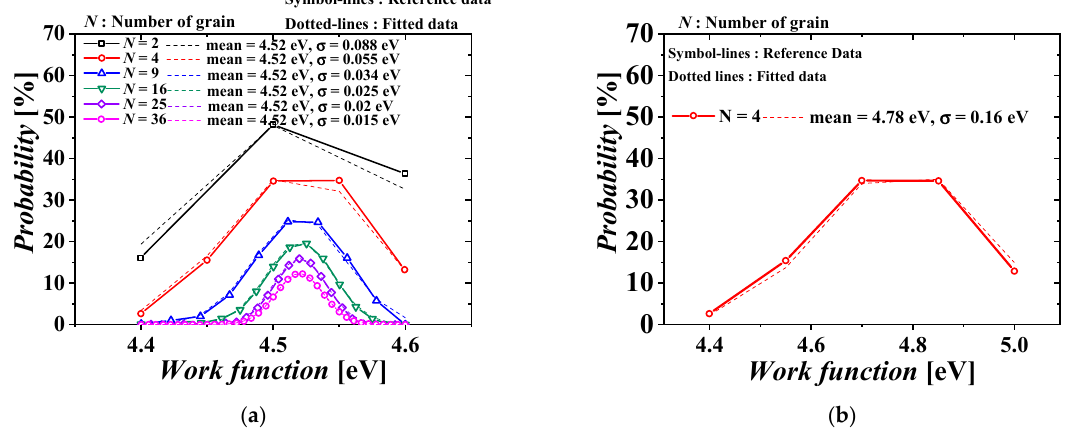
Figure 2. Work-function distributions in metal gates of each tier MOSFET. ( a ) TiN metal gate with the grain size of 5 nm of the top-tier NMOSFET (NMOS) and ( b ) MoN metal gate with the grain size of 15 nm of the bottom-tier PMOSFET (PMOS).